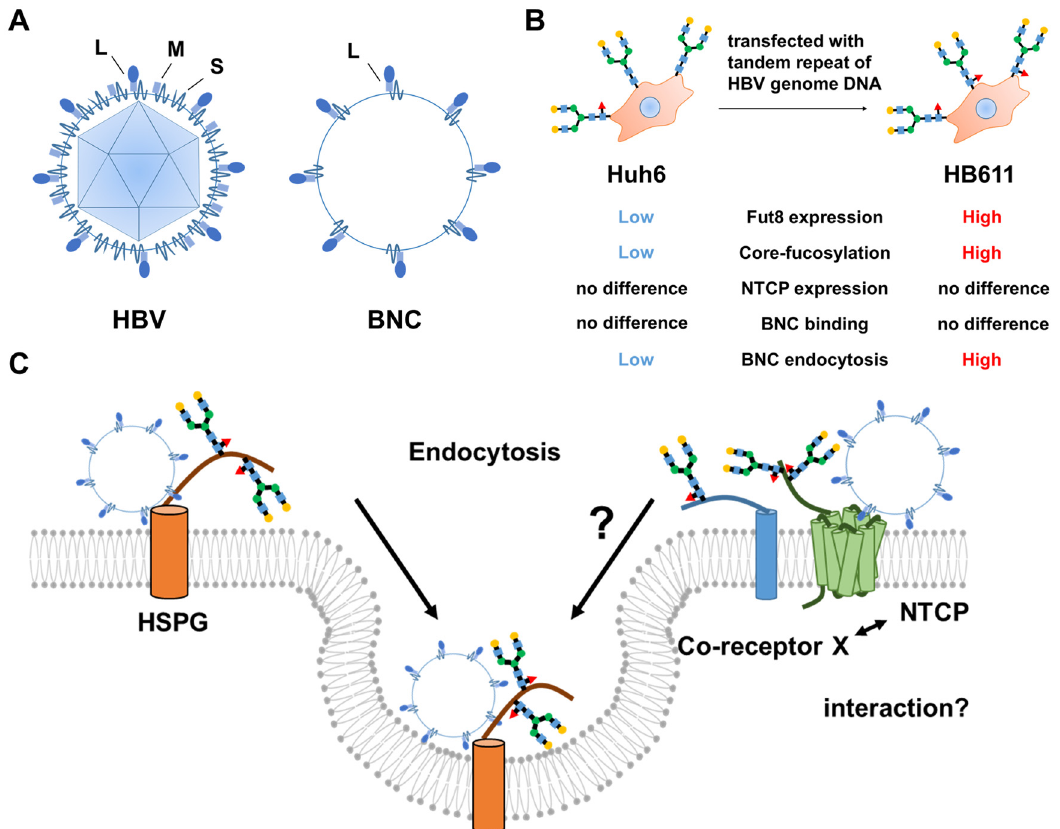
Figure 2. HBV infection and core-fucosylation. ( A ) Structure of BNCs. BNCs consist of only an envelope with large S proteins. Large S proteins bind to NTCP, a cell surface receptor for HBV entry into hepatocytes, through the preS1 region. ( B ) Difference between Huh6 and HB611 cells. HB611 cells were established from Huh6 cells transfected with tandem repeat HBV genome DNA. There were no differences in NTCP expression or BNC binding between Huh6 and HB611 cells. However, HB611 cells were highly core-fucosylated, and BNC endocytosis into HB611 cells was increased. ( C ) Summary of our results and speculation. BNC/HBV internalization into hepatoma cells occurs in a core-fucose-dependent manner. However, it remains unknown which glycans are important in NTCP and/or a putative co-receptor X.